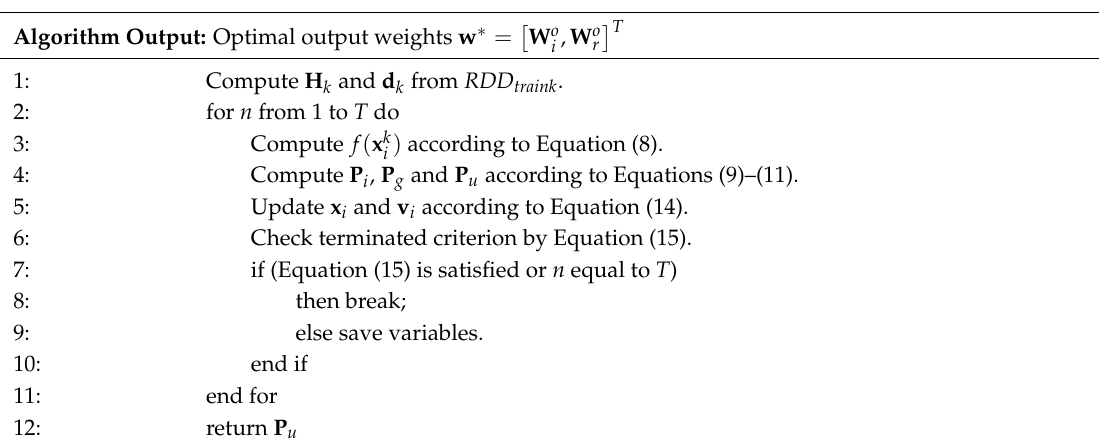
Algorithm 1 Training algorithm for PPSO-based ESN at k- th